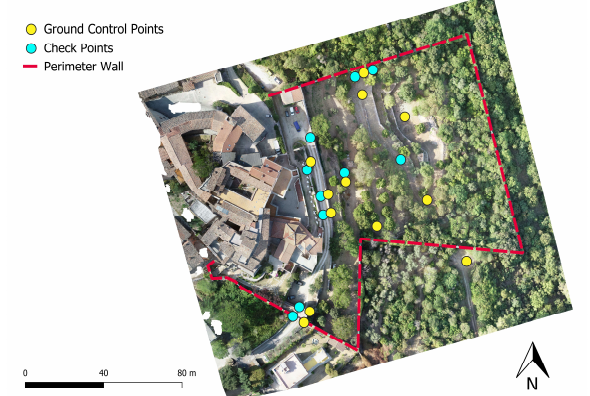
Figure 5 . Distribution of GCPs and CPs over the survey area.